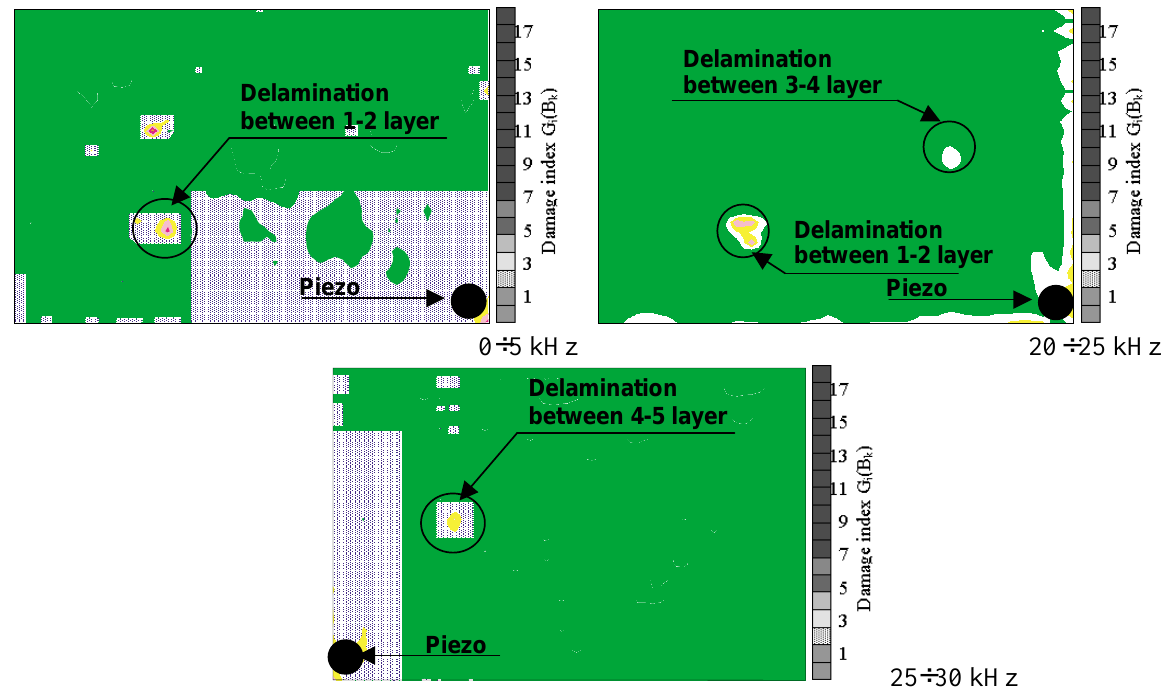
Fig. 13. Damage Index map on the composite panel in different frequency bands (experimental data).